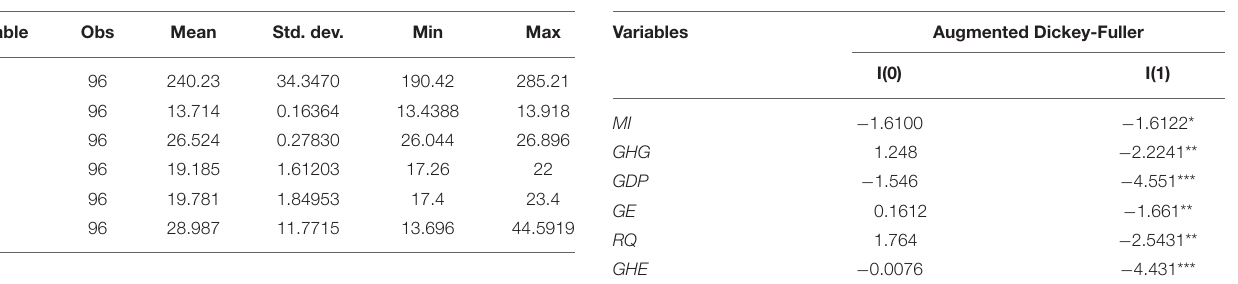
TABLE 4 | Descriptive statistics. TABLE 5 | Unit root